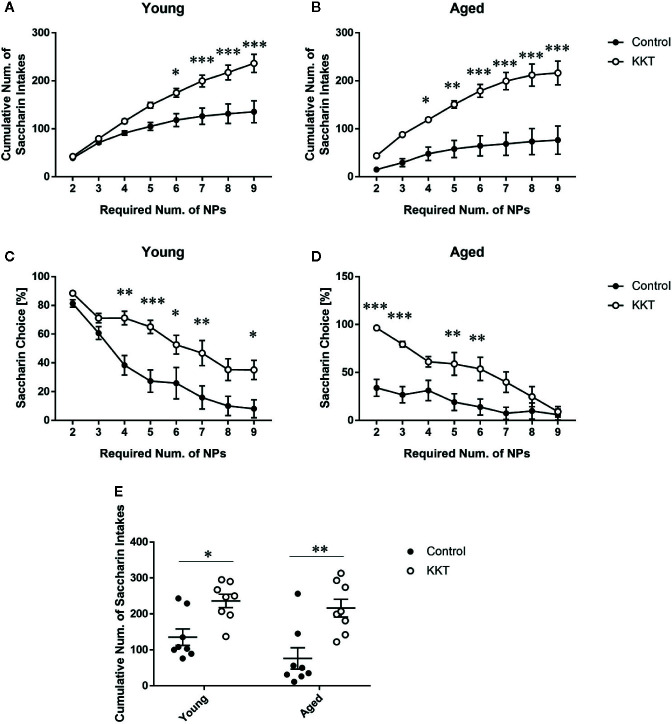
Effects of KKT on effort-based decision making. (A–D) Effects of KKT on cumulative saccharin intake attained by young (A) and aged (B) groups, and saccharin preference in young (C) and aged (D) mice during a progressive ratio task. Data are expressed as mean ± SEM (n = 8). *: P < 0.05; **: P < 0.01; ***: P < 0.001, Bonferroni’s multiple comparison following two-way repeated measures ANOVA. (E) Age-related effects of KKT on total saccharin solution volume obtained. Scatterplot data are presented as mean ± SEM (n = 8). Statistical analysis was conducted with two-way ANOVA followed by Bonferroni multiple comparison (*: P < 0.05; **: P < 0.01).